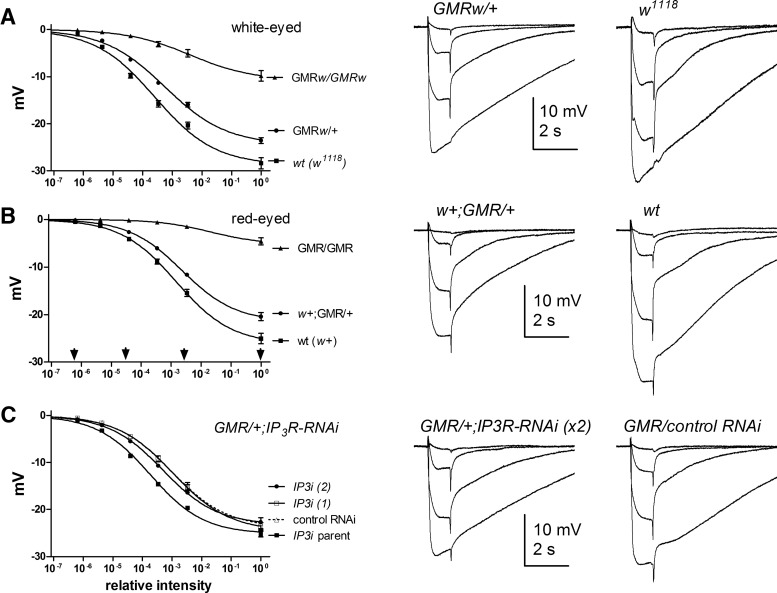
GMRGal4 ERG phenotypes. Response intensity (V/log I) functions measured from ERG (plateau at end of 1-s stimuli). ERGs from flies with one copy of GMRw (A) or GMR (B) were significantly reduced in amplitude across all intensities compared with respective eye color–matched wild-type controls (mean ± SEM, n = 10–17 flies; p < 0.0001; two-tailed t tests). A, GMRw/+ (F1 of Sp/Cy;GMRw × w1118 compared with w1118). Data from Sp/Cy;GMRw/GMRw parent also plotted. Representative traces on right (at intensities marked by arrows in B). B, F1 of w+;GMR × wild-type (red-eyed) cross compared with red-eyed wild-type (w+) and GMR/GMR homozygote, n = 10–14 flies. C, In contrast, ERGs of GMR/+;IP3R-RNAi (one copy, n = 16, or two copies, n = 19) were similar to a control GMR/+ (control RNAi; n = 10, dotted line). Flies were F1 of GMRGal4;IP3R-RNAi/TM6 × UAS-IP3R-RNAi or UAS-fwd-RNAi (control RNAi line chosen because it has similar eye color, but no effect on photoreceptor physiology). However, all GMR/+ genotypes were less sensitive (p < 0.0001) than the IP3R-RNAi parent stock (n = 7). Maximum intensity (10°) equivalent to ∼107 effectively absorbed photons per photoreceptor in wild-type (w1118).